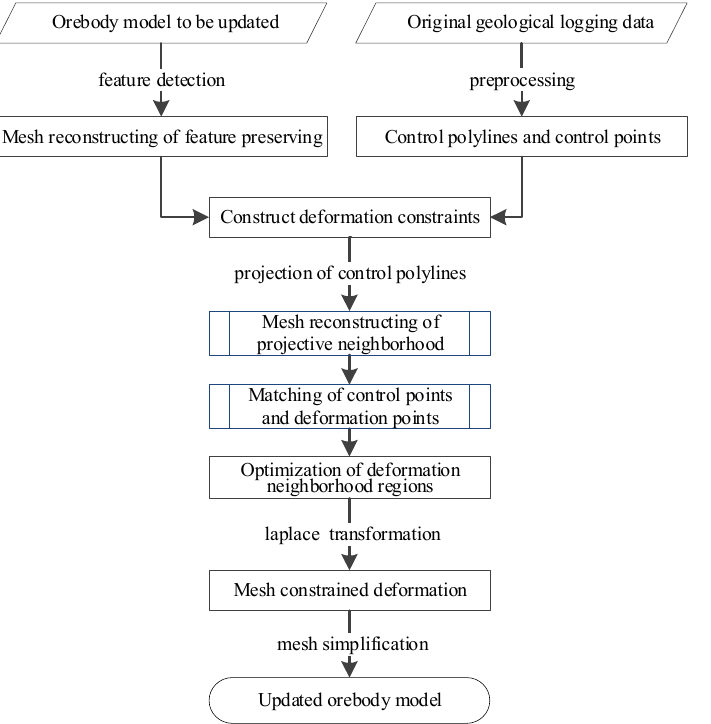
Figure 1. Local dynamic updating method of the orebody model based on mesh reconstruction and mesh deformation. mesh